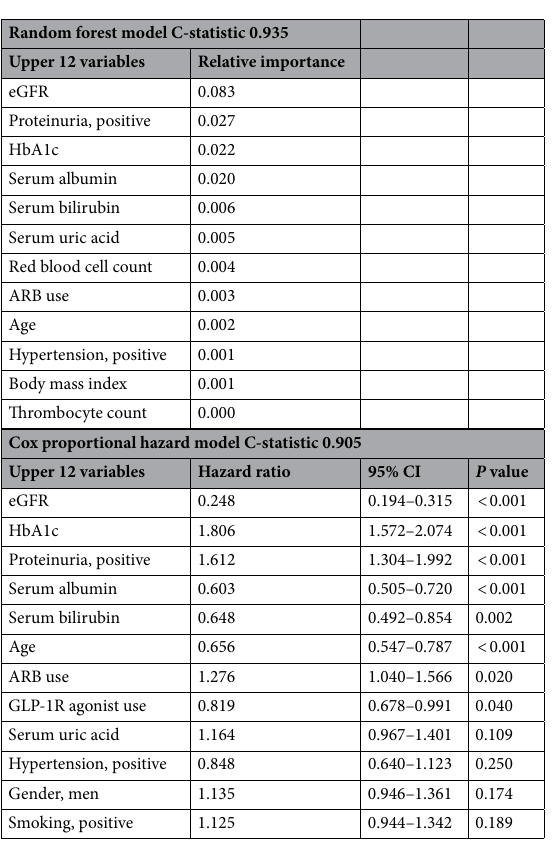
Table 2. Relative importance of variables for predicting end-stage kidney disease (ESKD) using the random forest model and Cox proportional hazard model. eGFR estimated glomerular filtration rate, HbA1c hemoglobin A1c, ARB angiotensin II receptor blocker, GLP-1R glucagon-like peptide 1